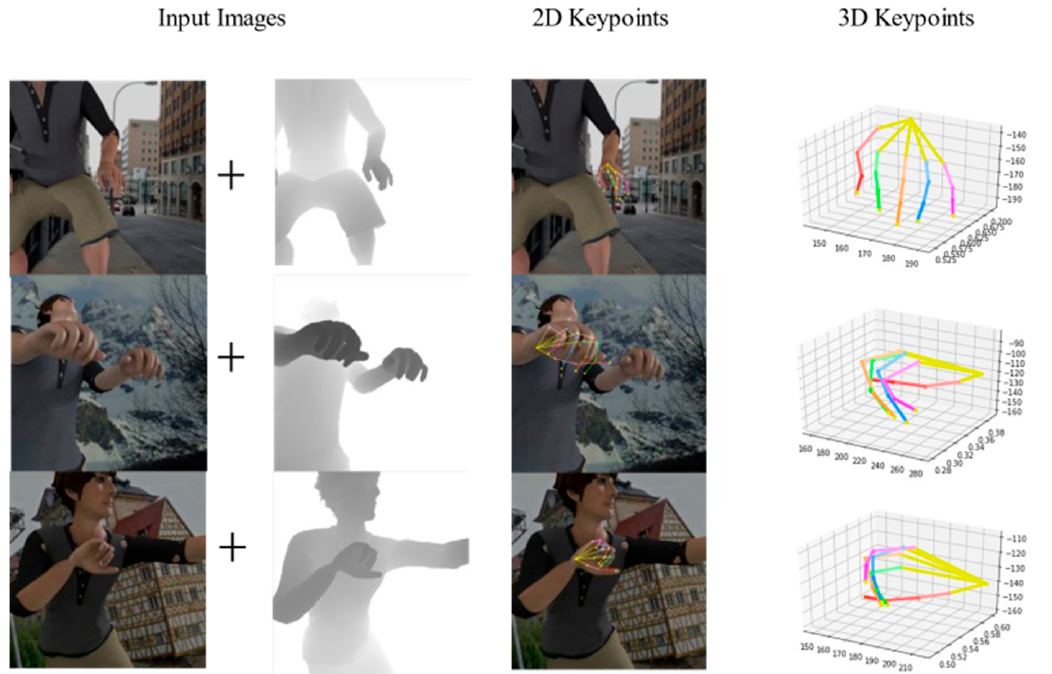
Figure 1. We propose a novel method (CrossFuNet) to fuse depth and RGB information from RGB images and paired depth maps. Our method is able to estimate 2D and 3D hand-joint locations. The first column shows the input frames, while the second column and third column show our 2D and 3D key-point results on the RHD dataset, respectively.